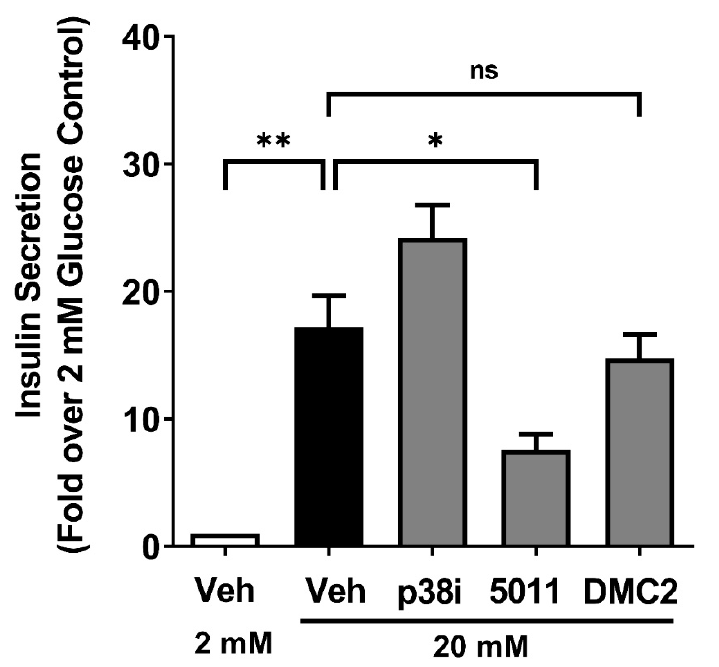
Figure 6. DMC2 does not impair glucose-stimulated insulin secretion. 832/13 cells were treated